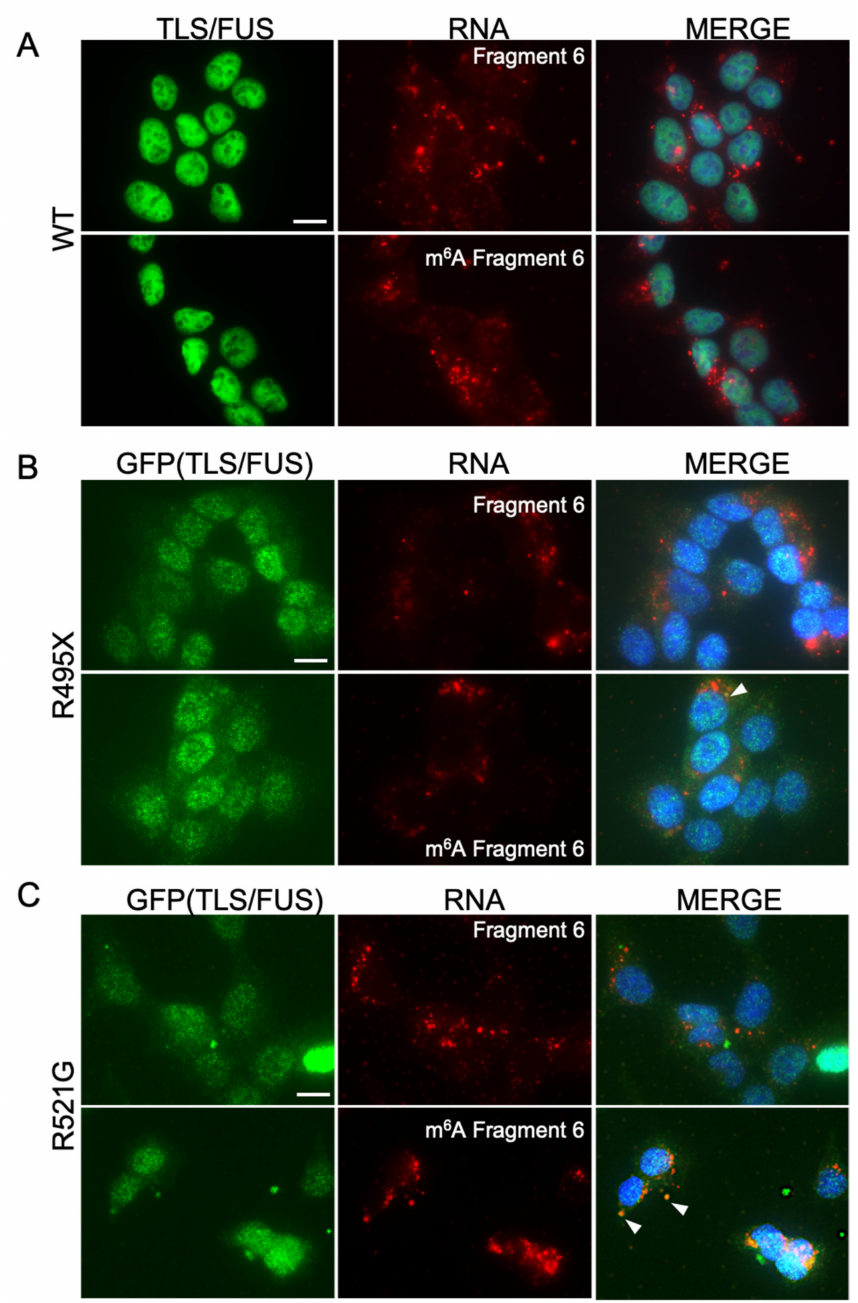
Figure 2. RNA fragments did not promote cytoplasmic TLS/FUS aggregation in HAP1 cells. ( A ) HAP1 cells were transfected with Cy5-labeled RNA Fragment 6 with or without m 6 A